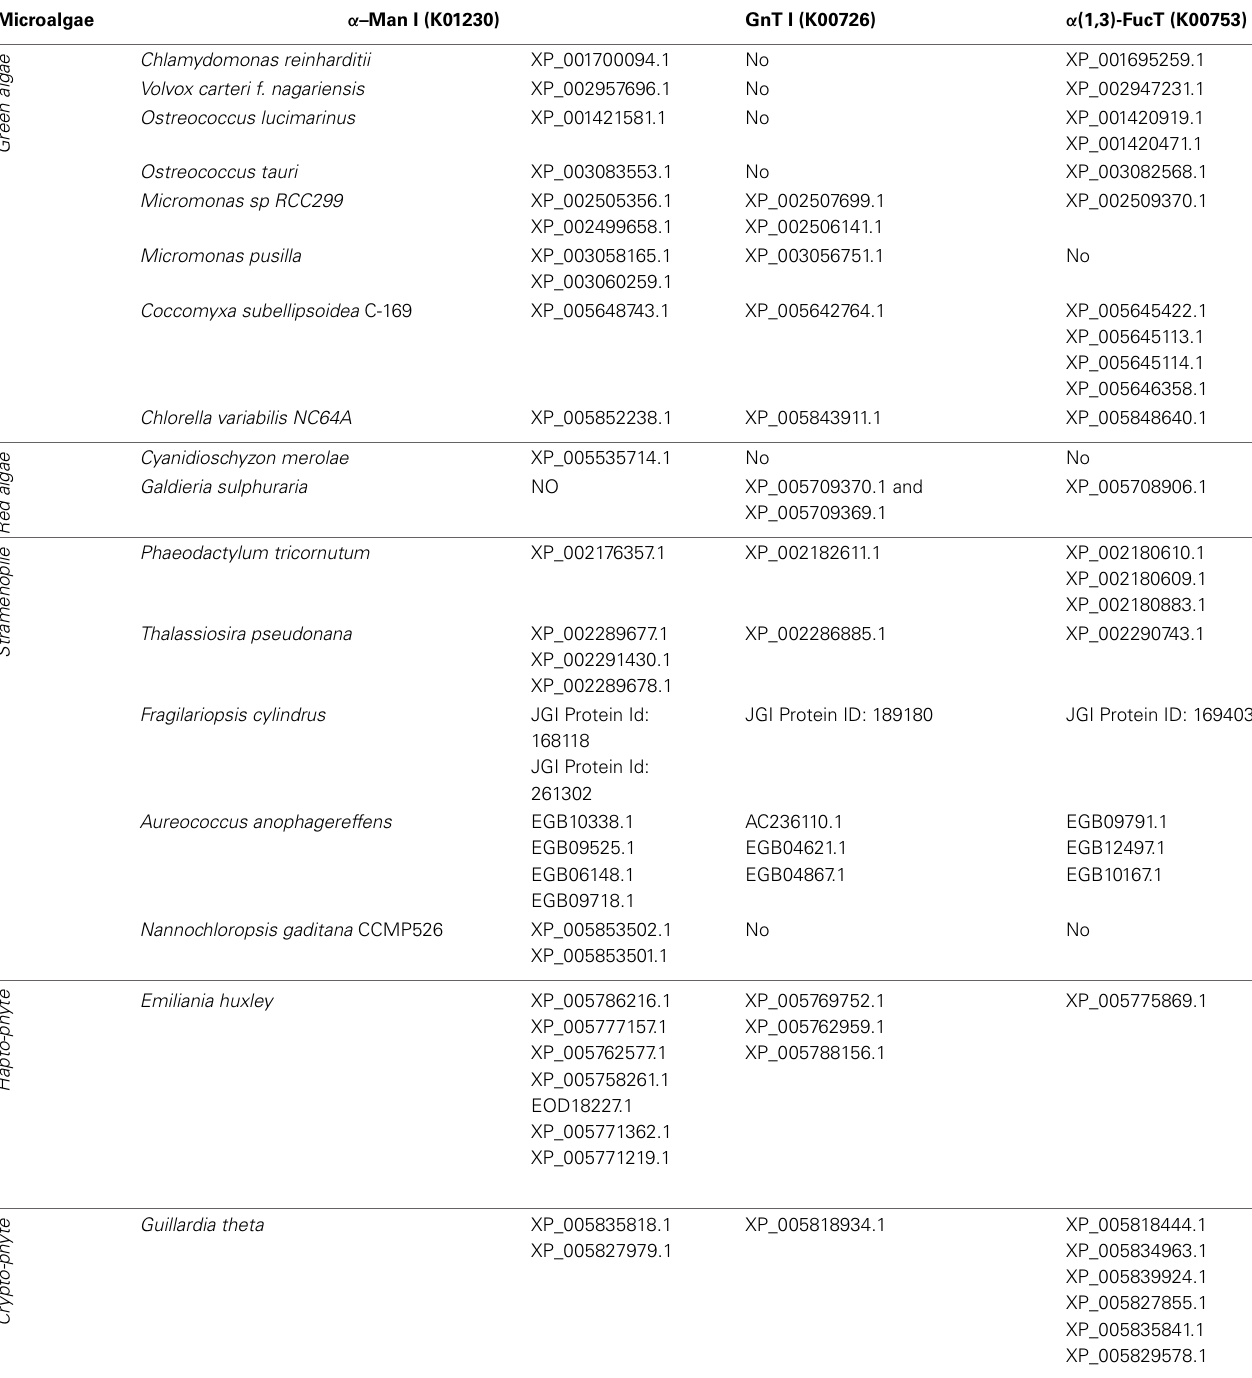
Table 2 | Genes predicted in microalgae genomes encoding proteins involved in N- glycan Golgi maturation such as α -Man I, mannosyl oligosaccharide alpha-1,2-mannosidase; GnT I, alpha-1,3-mannosyl-glycoprotein beta-1,2-N-acetylglucosaminyltransferase; α (1,3)-FucT, core α